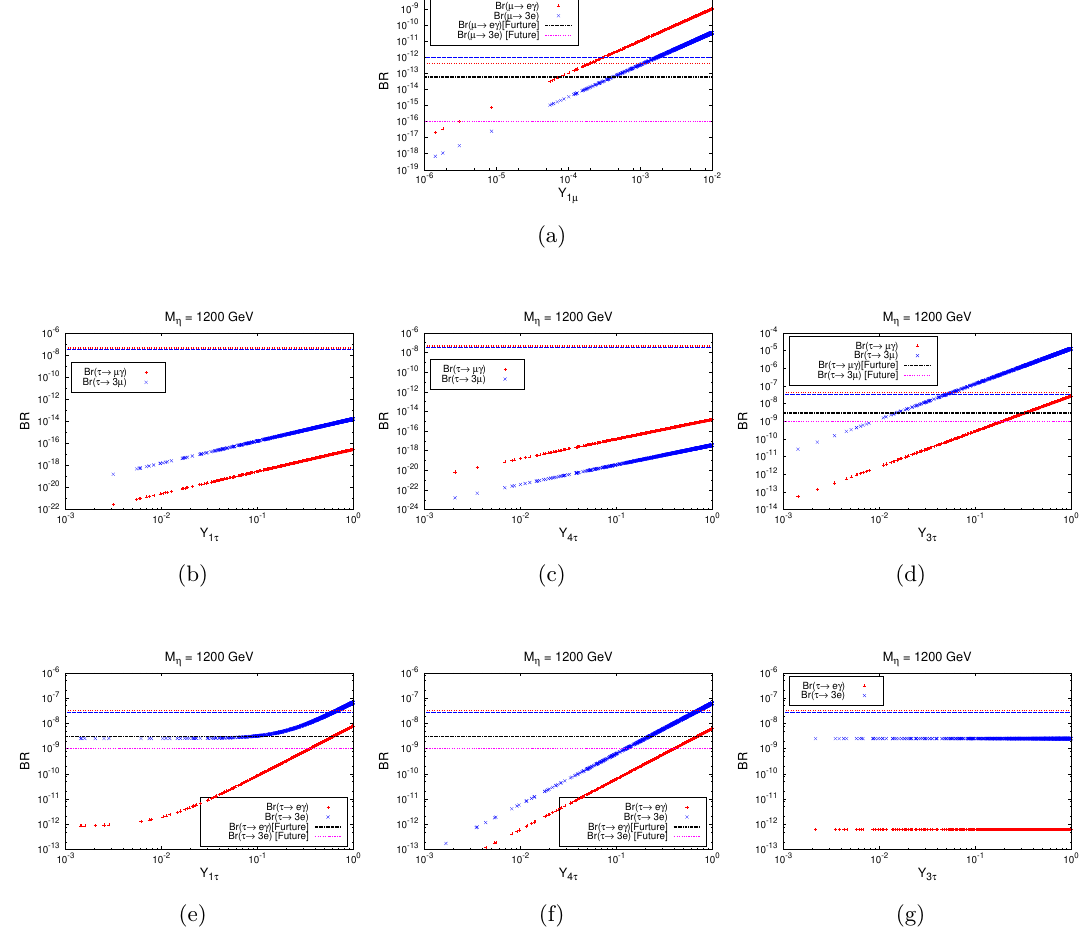
Figure 10 . Variation of Br( ‘ α → ‘ β γ ) (Red) and Br( ‘ α → 3 ‘ β ) (Blue) as a function of Y i‘ [ i = 1 , 3 , 4 ]. Input parameters are set as M = 1200 GeV, M = 130 GeV, M = 800 GeV, M = 190 GeV and η S χ 1 L 2 = 120 GeV. In the µ -sector, i.e., for plot (a) the e and µ -specific couplings are fixed at those M χ 0 values which are mentioned in the text. In the τ -sector, we chose for the plot (b) Y = Y = 0 , 4 τ 3 τ (c) Y = Y = 0 , (d) Y = 0 & Y = 0 . 01 , (e) Y = 0 . 01 & Y = 0 , (f) Y = Y = 0 and (g) 1 τ 3 τ 1 τ 4 τ 4 τ 3 τ 1 τ 3 τ Y 1 τ = 0 & Y 4 τ = 0 . 01 . In the plots (a), (d), (e), (f) the projected future bounds corresponding to Br ( ‘ ) and Br ( ‘ 3 ‘ ) have been marked with the black and magenta horizontal α → ‘ β γ α → β lines